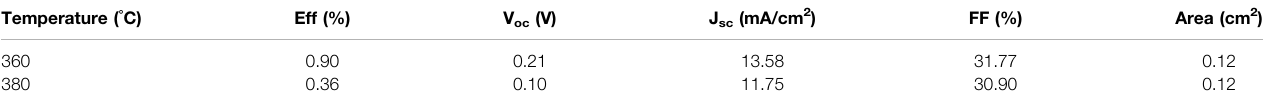
TABLE 3 | Device parameters of the CuSbS 2 thin- fi lm solar cells based on absorbers annealed at 360 ° C and 380 ° C for 30 min. Temperature ( ° C) Eff